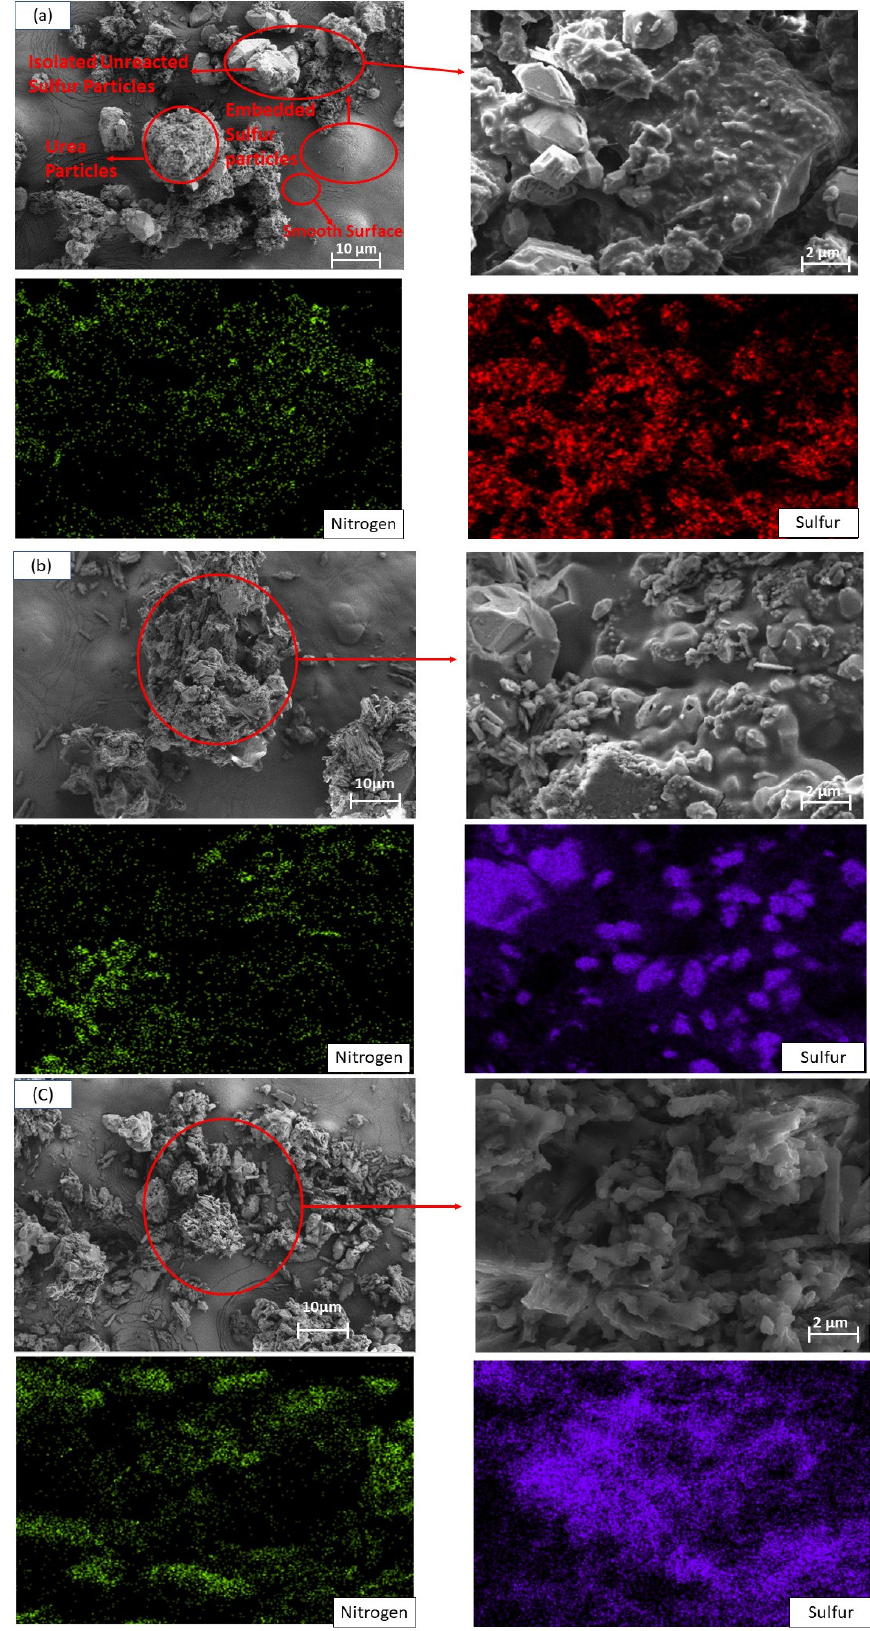
Figure 6. SEM micrographs of SUCFs along with EDX mapping with ( a ) 50, ( b ) 60, and ( c ) 70 wt% S . The release profile of all SUCFs along with the pristine urea is shown in Figure 7. As can be witnessed from the figure, the N release longevity is highly dependent on the initial S loading of SUCFs as the S loading increases, which results in the increase of the unre- acted S leading to micropores generation on the surface of the SUCFs, resulting in quick release of the nutrients. The pristine urea released almost 99.9% of its total N within 24 h, whereas only 13.7%, 25.0%, and 40.0% of total N of SUCF-50, SUCF-60, and SUCF-70 was released. Initial release rate of N from the SUCFs increases with the increase of S loading, which demonstrates the strength of the composites to delay the N release; the lesser the S content, the stronger it will be to prevent the N loss. SUCF-50 outperformed all SUCFs in term of N release longevity, as it released only 70% of its total N after 16 days of incubation